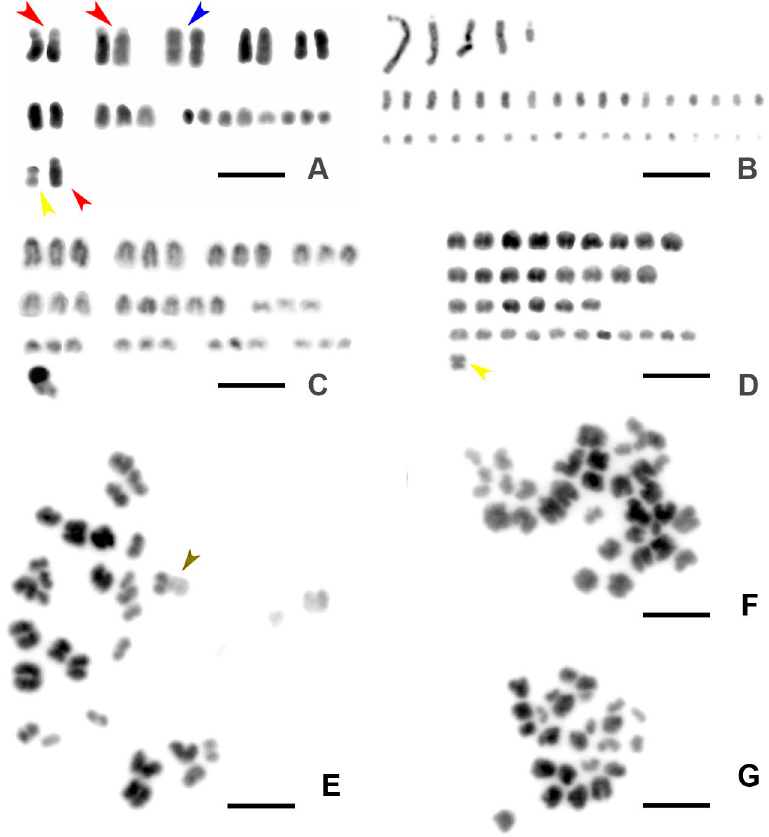
Figure 3. Karyotypes and metaphases of selected populations of E. virens analyzed in this study and representing the most important traits of chromosome morphology. ( A ) Sicily, a sexual female, red arrowheads show chromosomes with satellites, blue arrowhead shows a pair of metacentric chromosomes, yellow arrowhead shows a small metacentric chromosome; ( B ) E. virens , Sicily, the same sexual female as in ( A ); ( C ) E. virens , Valencia, Triops Pond, Spain, an asexual triploid female; ( D ) E. virens , Normandy, France, an asexual triploid female, yellow arrowhead shows a small disparate metacentric chromosome; ( E ) E. virens , Spain, San Carlos (Bull Pond), a female of a mixed population, brown arrowhead shows a morphologically distinguishable chromosome; ( F ) E. virens , France, Normandy, an asexual triploid female; ( G ) E. virens , Sicily, a diploid sexual female. Chromosome preparations were stained with 4’,6-diamidino-2-phenylindole (DAPI) and inverted. Scale bars indicate 3 µm.